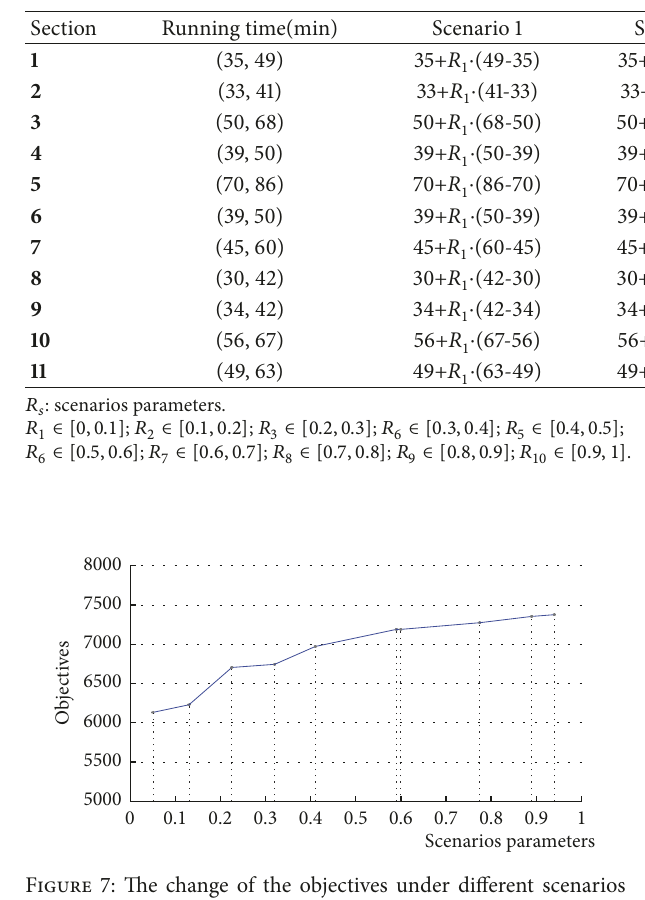
Table 6: Scenarios setting example: downstream of high-speed railway.